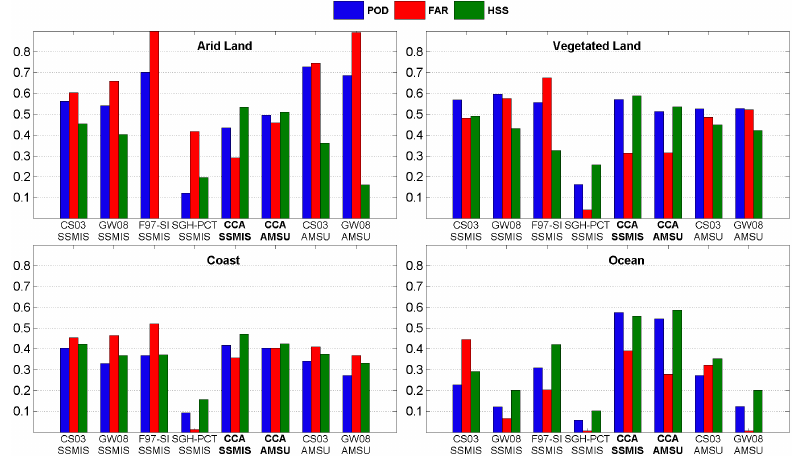
Figure 5. Skill score comparison of the CCA algorithm with other precipitation detection algorithms with rain/no-rain threshold (“truth” from PR 2A25) equal to 0.1mmh − 1 .